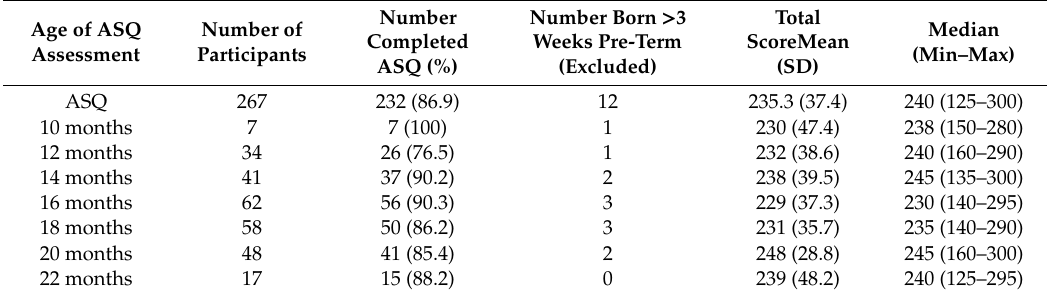
Table 2. Number of children assessed with each age-specific Ages and Stages Questionnaire version, number excluded due to preterm birth and mean / median total ASQ